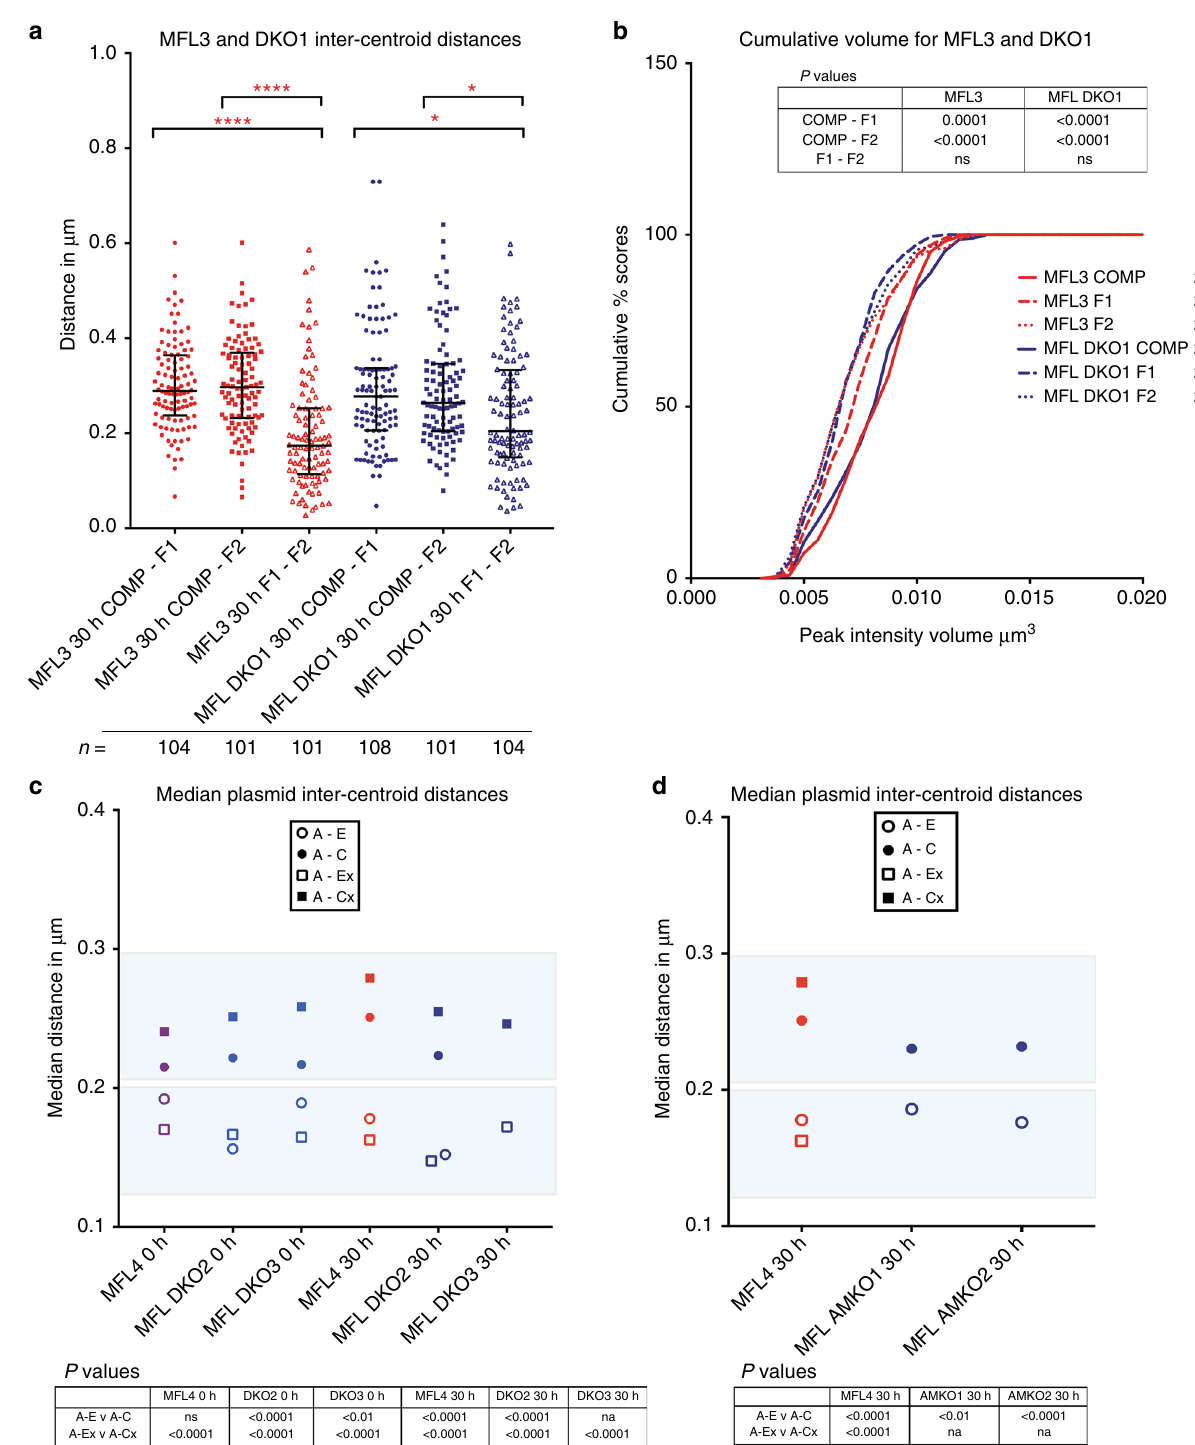
Fig. 8 The α -globin domain still forms in the absence of elements critical for α -globin expression. a Pairwise inter-centroid distances between three BAC probes in 30 h erythroblasts derived from littermates MFL3 (WT) and DKO1 (homozygous deletions for MCS-R1/R2). F1 – F2 are signi fi cantly closer than COMP-F1 and COMP-F2 in both WT ( p < 0.0001 for both) and DKO1-derived erythroblasts ( p = 0.0374 and 0.0468 respectively). Total number of measurements is indicated by ‘ n ’ . b Cumulative frequency plots of BAC signal volumes in 30 h erythroblasts from MFL3 and DKO1. The larger COMP volumes are arrowed. Total number of measurements is indicated by ‘ n ’ . c Median inter-centroid distances between four plasmid probe pairs at MFL 0 h and 30 h from littermates WT MFL4 and two homozygous double knockout embryos DKO2 and DKO3. Light blue shading emphasises the shorter distances within the self-interacting domain in both WT and knockouts. See Supplementary Fig. 6 for the complete data set. d Median inter-centroid distances between plasmid probe pairs A-Ex (represented as A-E distance because of a 16 kb α -globin gene deletion) and A-C at MFL 30 h in two α -globin knockout lines from littermates AMKO1 and AMKO2, plotted against WT MFL4. Light blue shading is as for c . See Supplementary Fig. 6 for full data. All p values are derived by a Kruskal – Wallis test with Dunn ’ s multiple comparisons. ns not signi fi